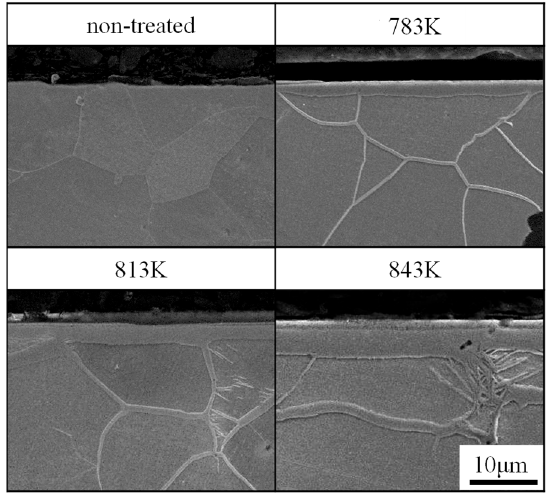
Figure 3. Cross-sectional SE images of ASPN-treated plate samples.